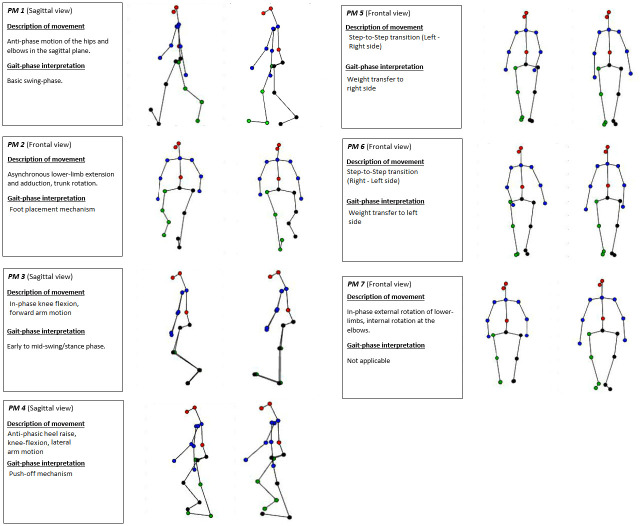
Summaries of each of the validated PMk along with their respective graphical representations to the right.An amplification factor of 2 was used to provide clarity to more subtle movements in visualizations.